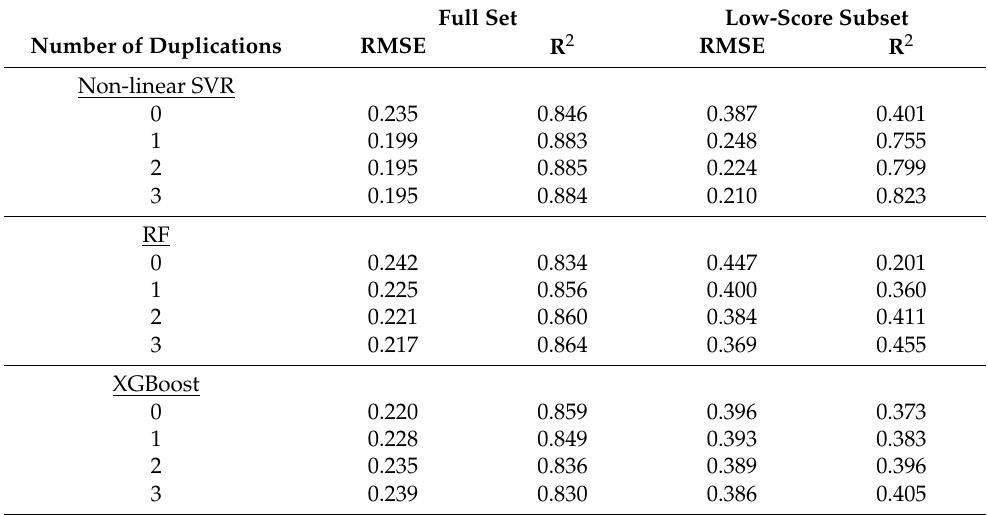
Table 4. RMSE and R 2 values for the Non-linear SVR, RF, and XGBoost regression models for the full set and the low-score subset with 0 to 3